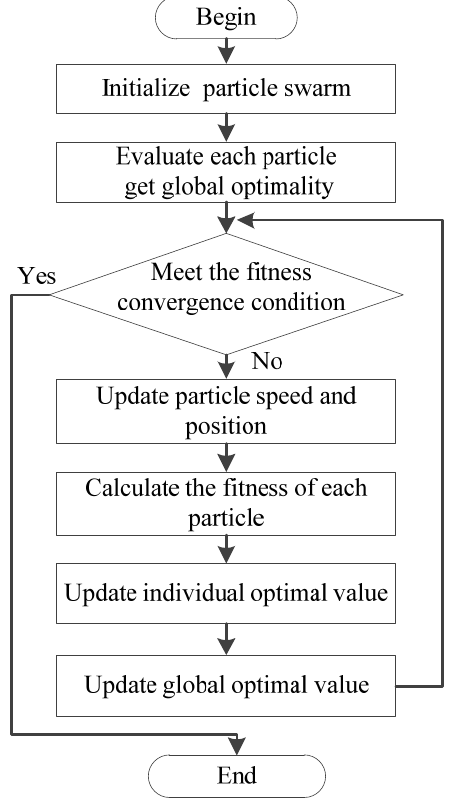
Figure 2. Flow chart of particle swarm optimization.